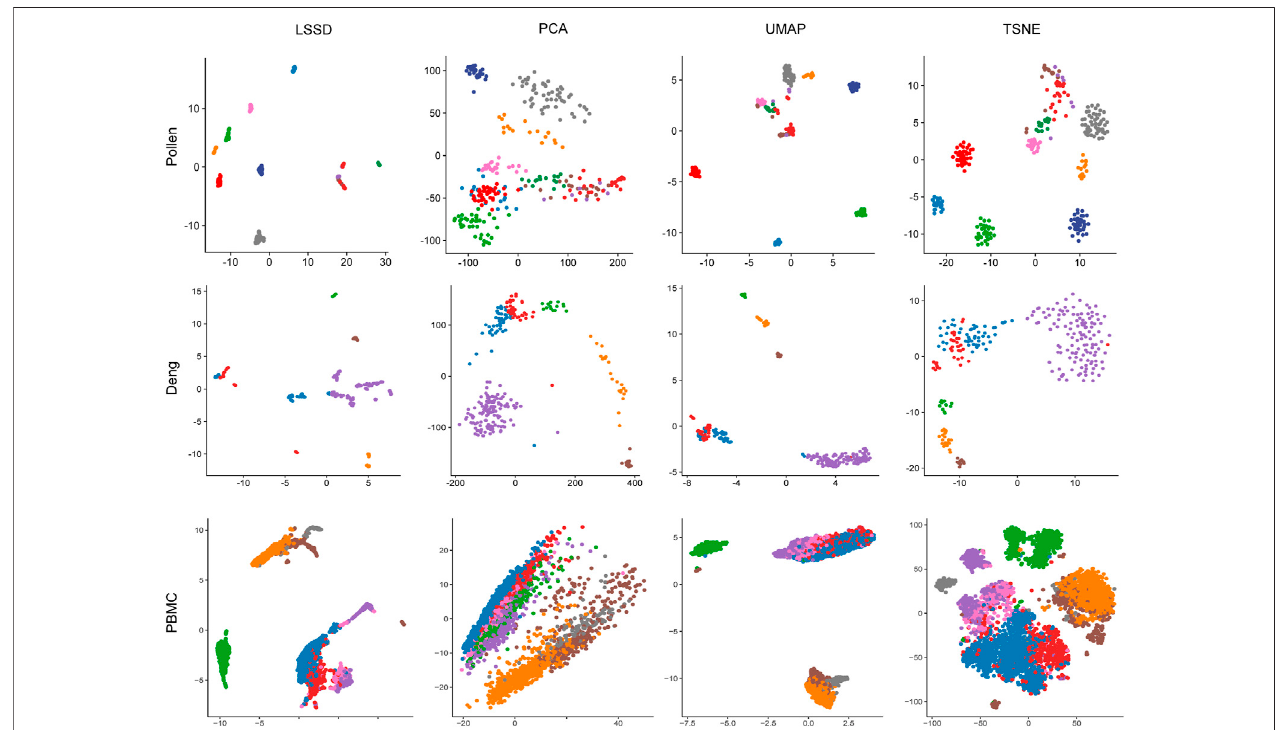
FIGURE 6 | Comparison of 2D visualization using different dimension reduction methods on Pollen, Deng, and PBMC datasets. The diffused graph incorporating the UMAP method reveals more cohesion cluster representation. Each color represents a cell population with true labels.